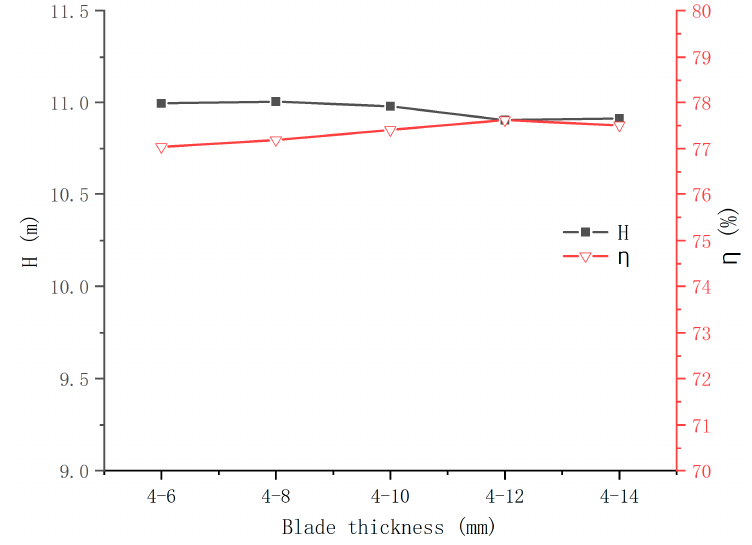
Figure 12. Pump performance of VTB.